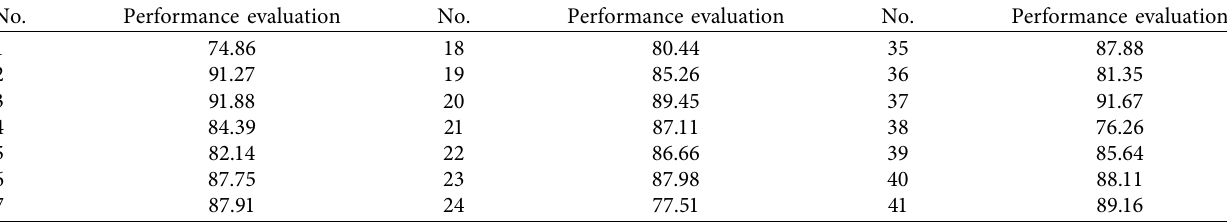
Table 4: Performance management evaluation of financial budget implementation in colleges and universities.